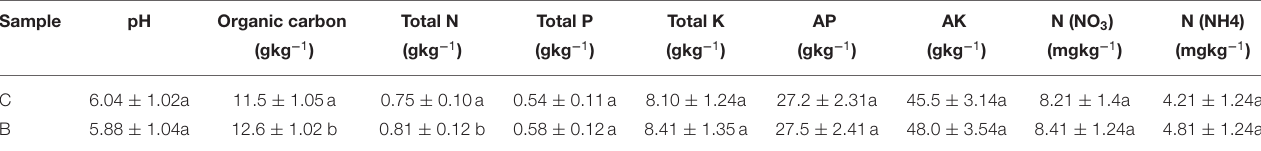
TABLE 1 | Soil chemical properties.